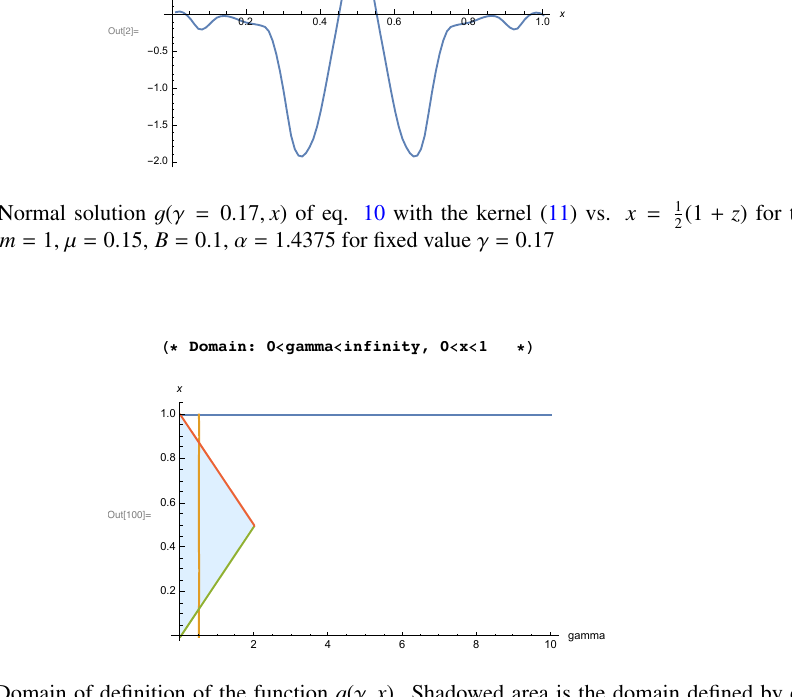
Figure 6. Domain of definition of the function g ( γ, x ). Shadowed area is the domain defined by eq. (14) where g ( γ, x ) =